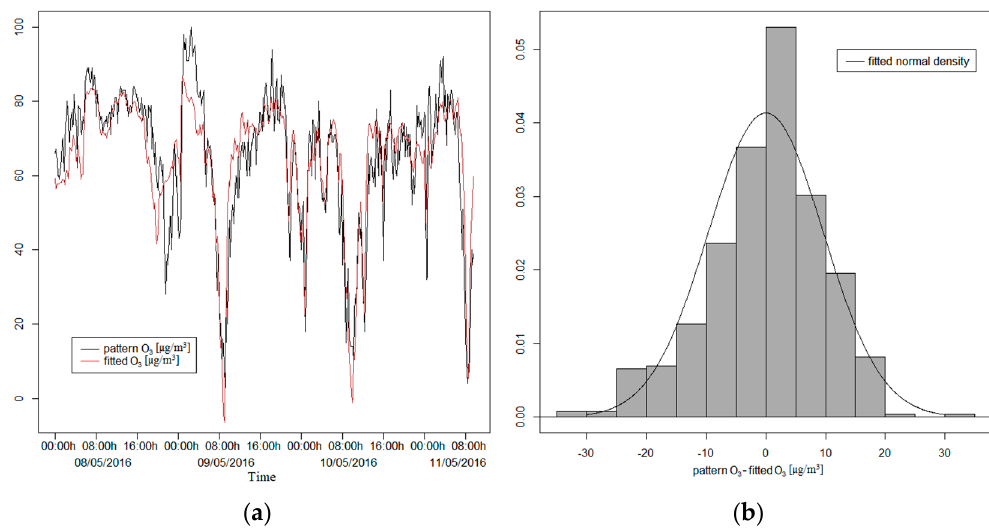
Figure 5. ( a ) The fitted values by the model and the pattern values for ozone; ( b ) the histogram of the net prediction errors of the model.